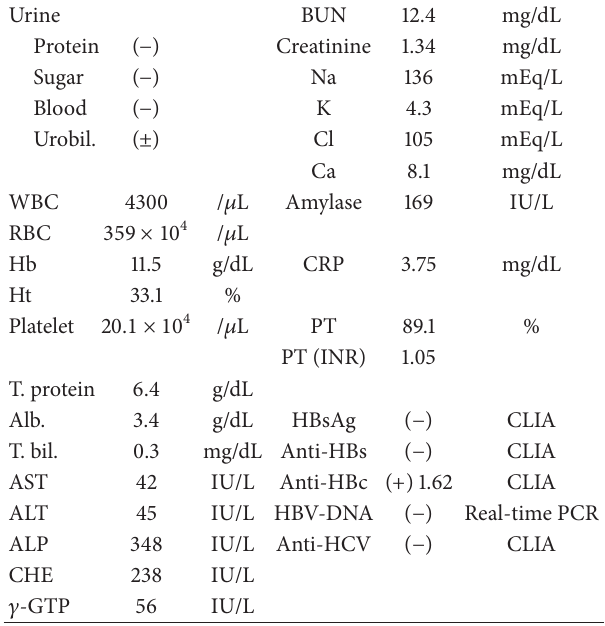
Table 1: Laboratory data on